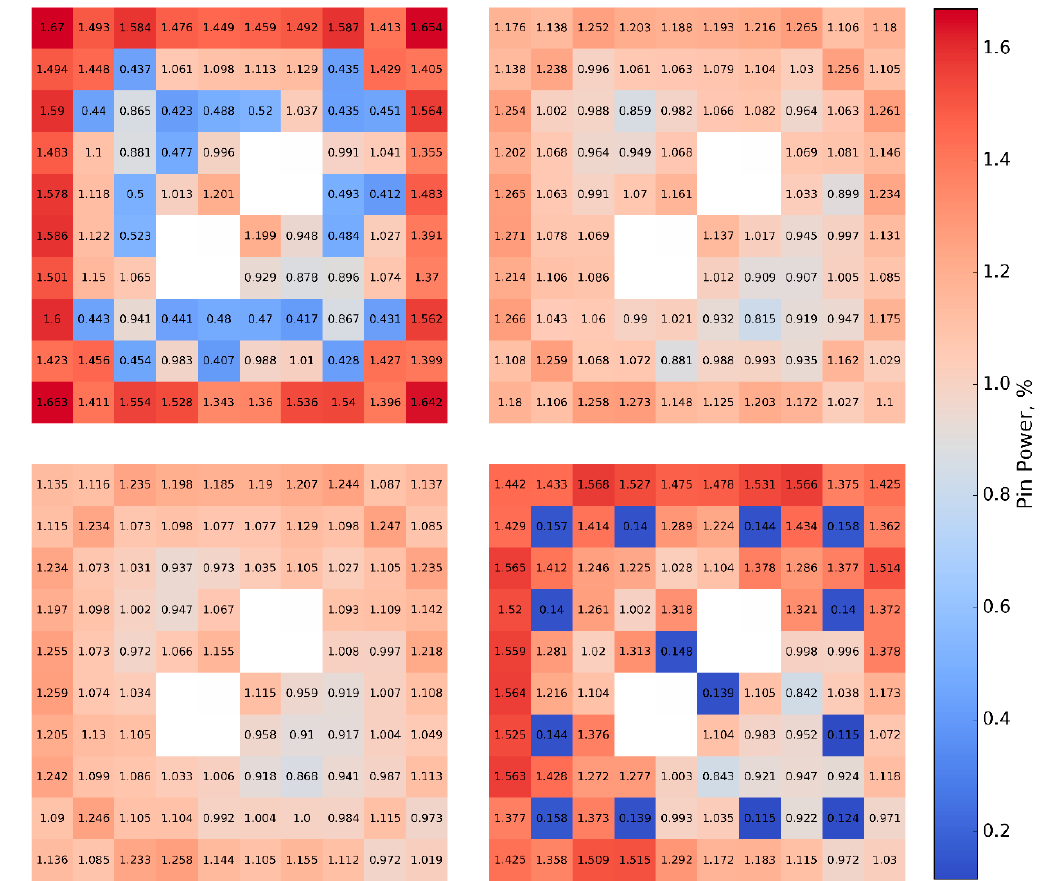
Figure 16. Single assembly pin power profile between iterations normalised to the total assembly power (100%). Top left , iteration zero, Top right , iteration one, Bottom left , iteration two and bot ‐ tom right , iteration three.